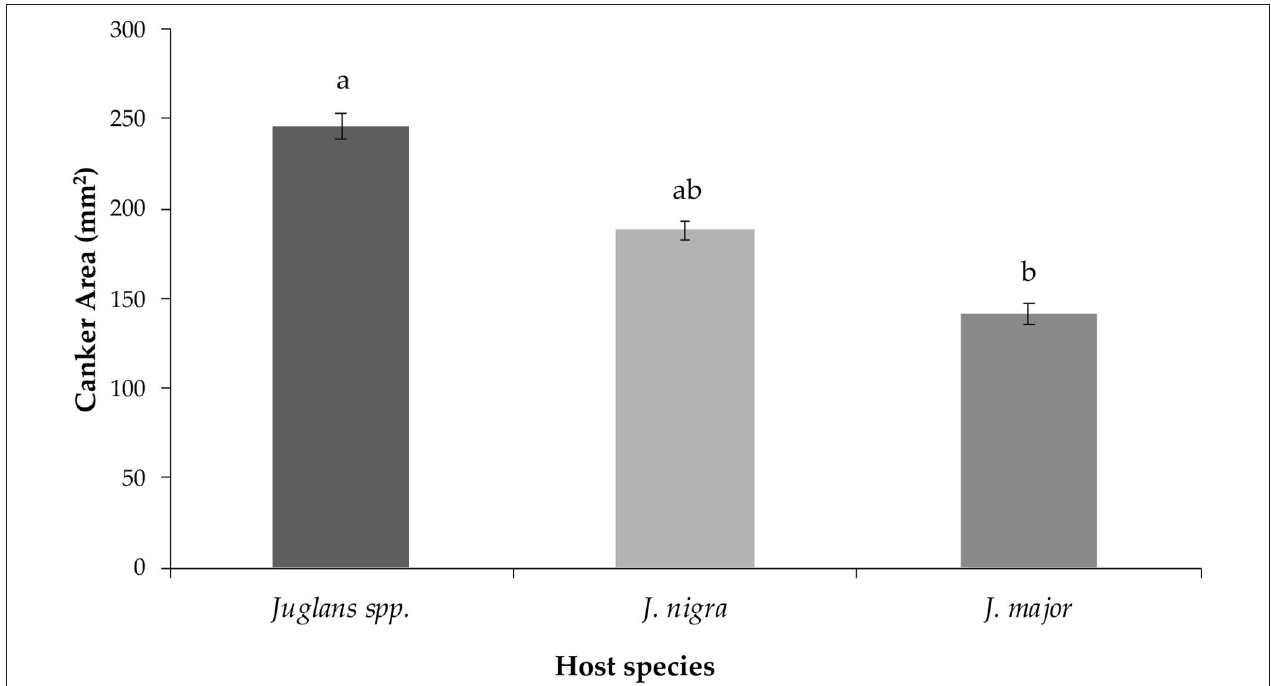
FIGURE 3 | Mean canker area measured for lesions induced by G. morbida isolates that were grouped based on Juglans species host source as follows: undetermined Juglans spp., Juglans major , and Juglans nigra . Within species, treatment mean separations were made using least square mean estimates calculated from rank-transformed canker areas and differ significantly ( P < 0.05; Tukey’s honestly significant difference) when indicated with different letters. Non-transformed data and standard errors are